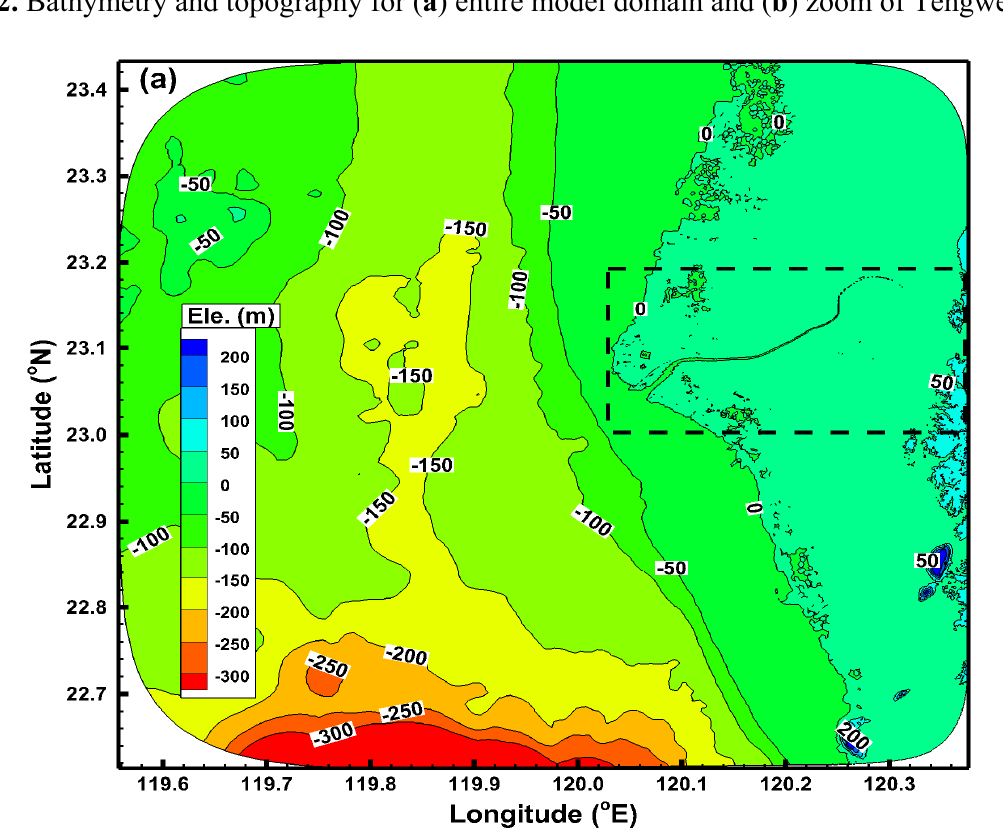
Figure 2. Bathymetry and topography for ( a ) entire model domain and ( b ) zoom of Tengwen